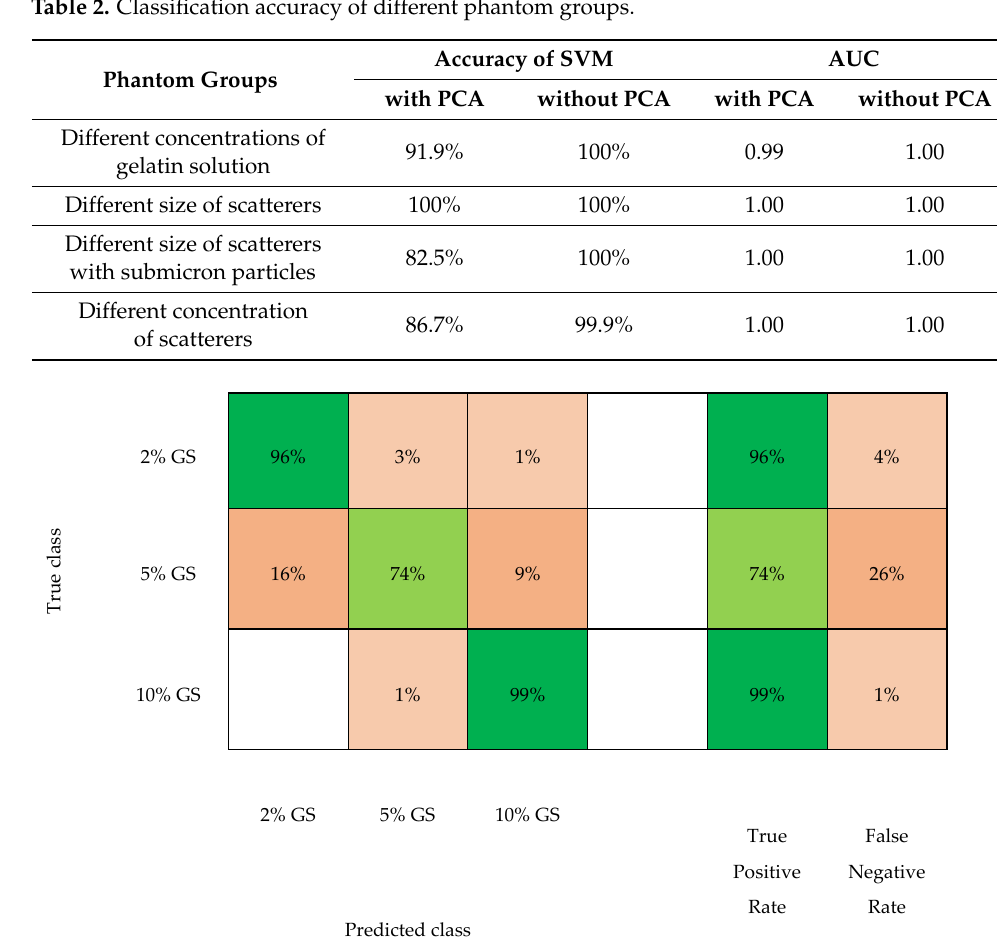
Figure 4. Original OCT image scans and threshold images of 384 nm ( a ), 1 µm ( b ), 2 µm ( c ), 5 µm ( d ) and 15 µm ( e ) PBs. Scatterers are more discernible in the threshold images. Table 2. Classification accuracy of different phantom groups.